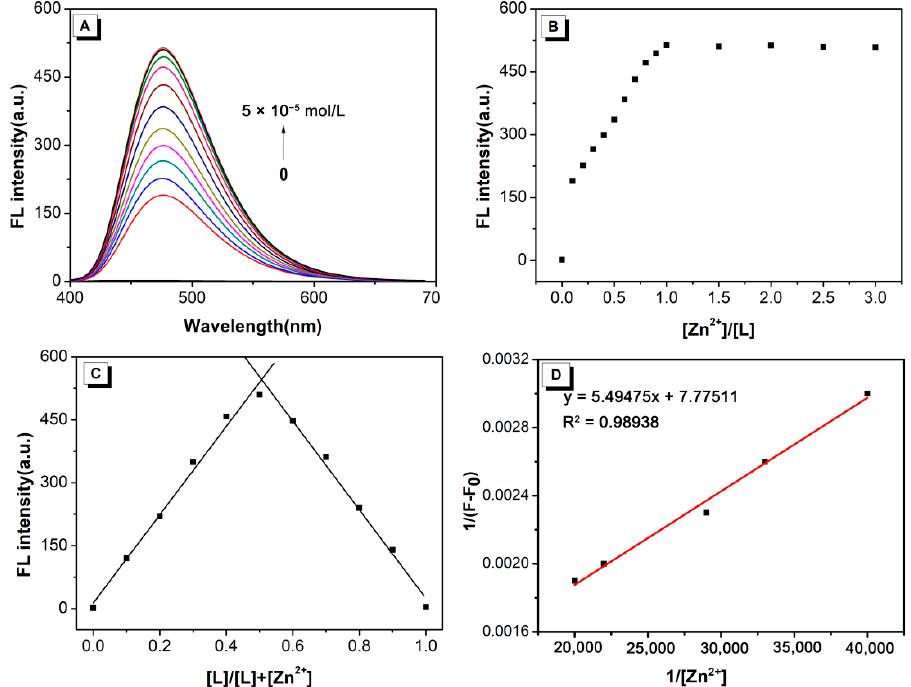
Figure 2. ( A ) Fluorescent titration spectra of L (50 μ mol/L) in the presence of different concentrations of ZnCl 2 . ( B ) The fluorescence at 475 nm of L as a function of the Zn 2+ concentration. ( C ) Job’s plot for the determination of the stoichiometry of L and Zn 2+ in ethanol, the total concentration of L and Zn 2+ was 50 µ M. ( D ) The Benesi-Hildebrand plot of 1 / (F − F0) versus 1 / [Zn 2+